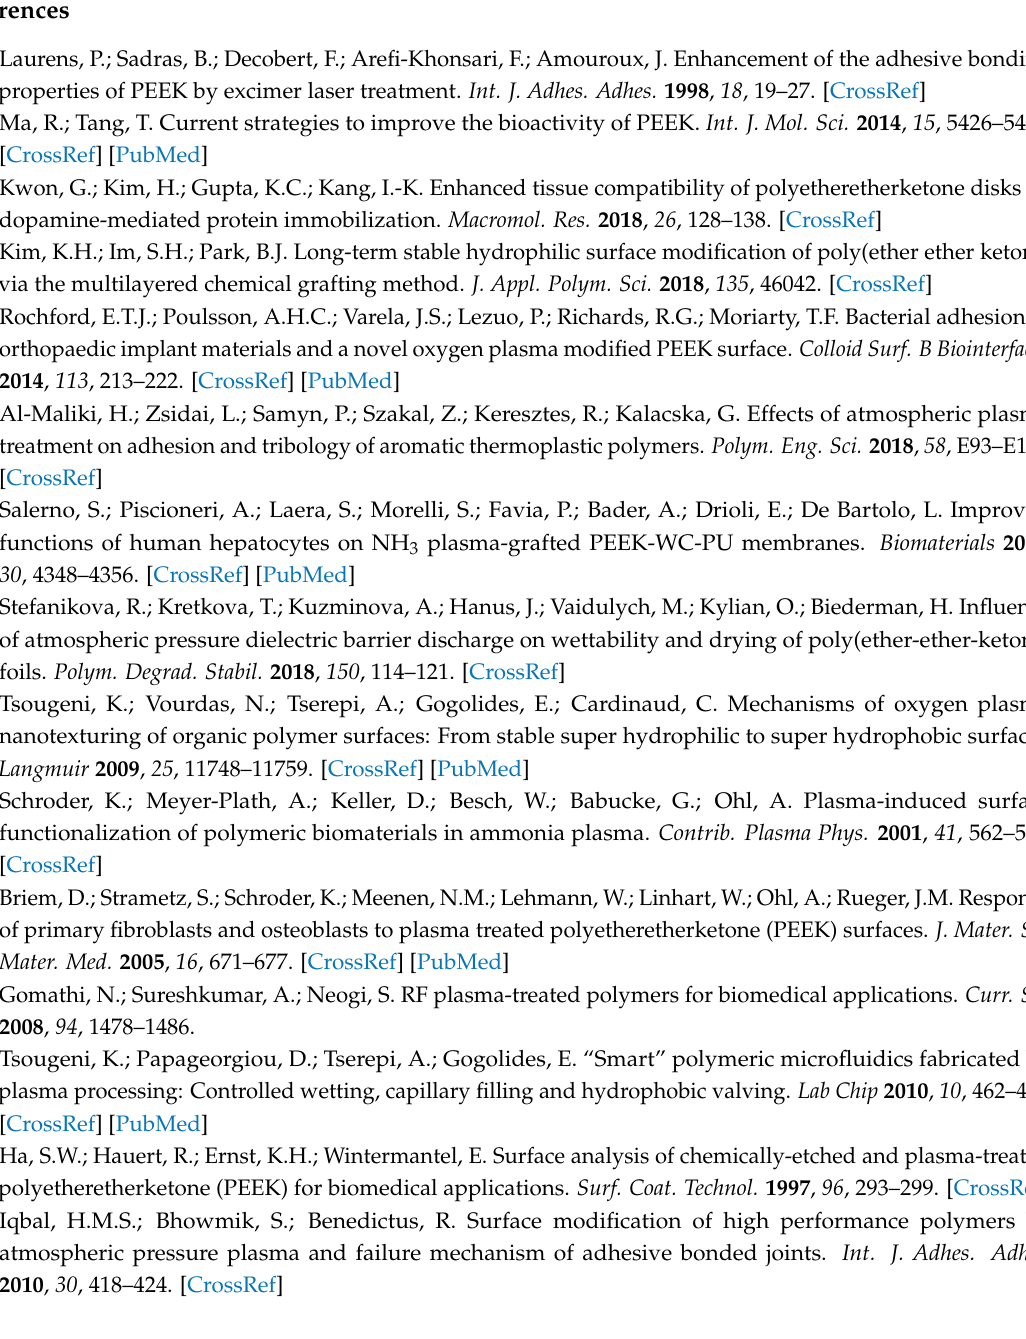
Figure S1: PEEK part modified with PAAm immersed in Eosin Y solution, Figure S2: EDX mapping of a PEEK surface, modified by PAAm during molding, Figure S3: Zeta potential as a function of pH for different samples, Figure S4: PEEK part modified with PAAm, immersed in AuNP solution, Figure S5: Photographs of different PEEK plates, spin-coated with a hydrogel, Table S1: Raw data of contact angle